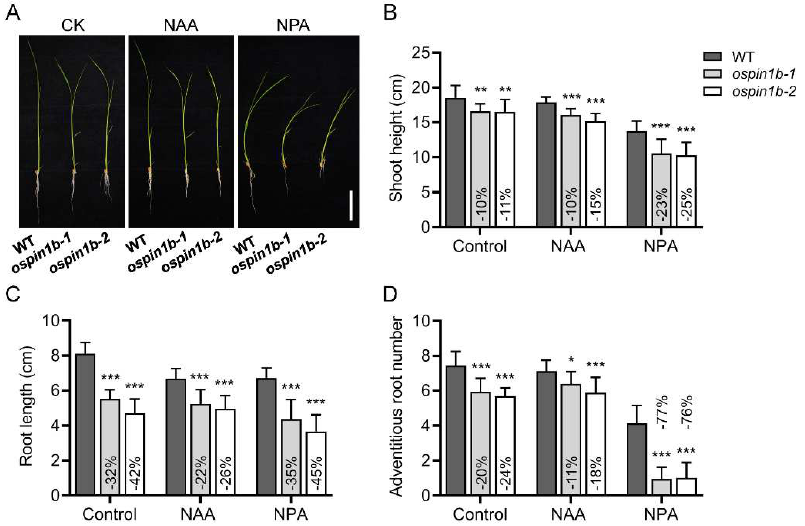
Figure 4. Response of ospin1b mutants to NAA or NPA treatment. ( A ) Phenotypes of wild-type (WT) and ospin1b mutants under normal, NAA or NPA treatments. Bar = 4 cm. ( B ) Statistical analysis of shoot height ( B ), root length ( C ) and adventitious root number ( C ) in WT and ospin1b mutants under normal, NAA or NPA treatments. Values are means ± standard deviation ( D ) ( n = 24). Data were analyzed by ANOVA and Tukey’s tests. *: p < 0.05; **: p < 0.01; ***: p < 0.001.